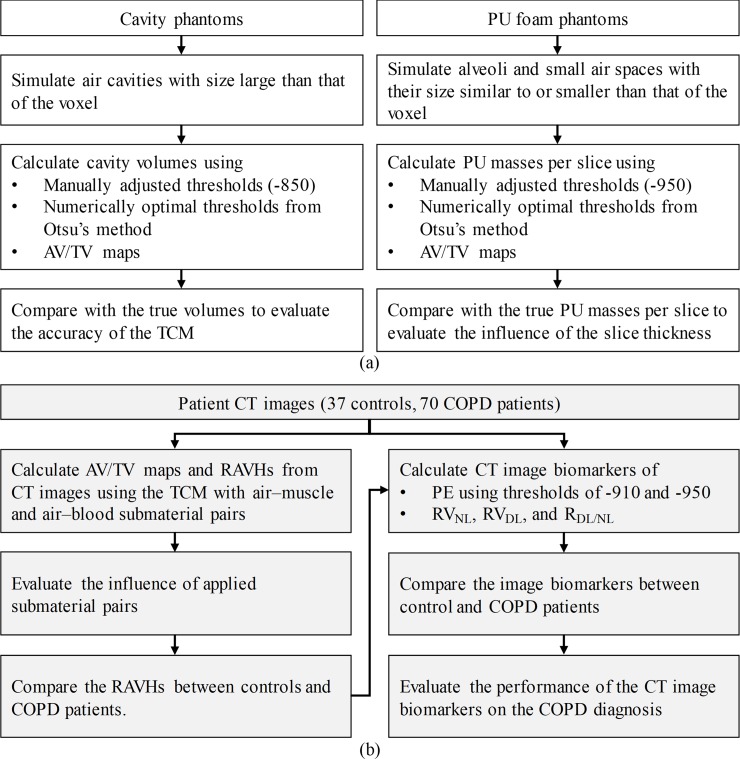
Block diagrams that represents the evaluation procedure of the (a) phantom and (b) patient studies performed in this study.